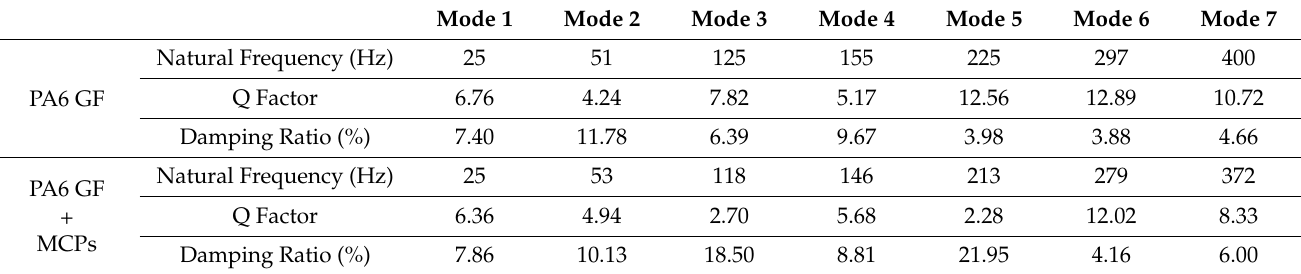
Figure 13. Effects of MCPs on vibration response summation of the roof-rack specimen. Table 4. Vibration characteristics from FRF curves from Figure 13.